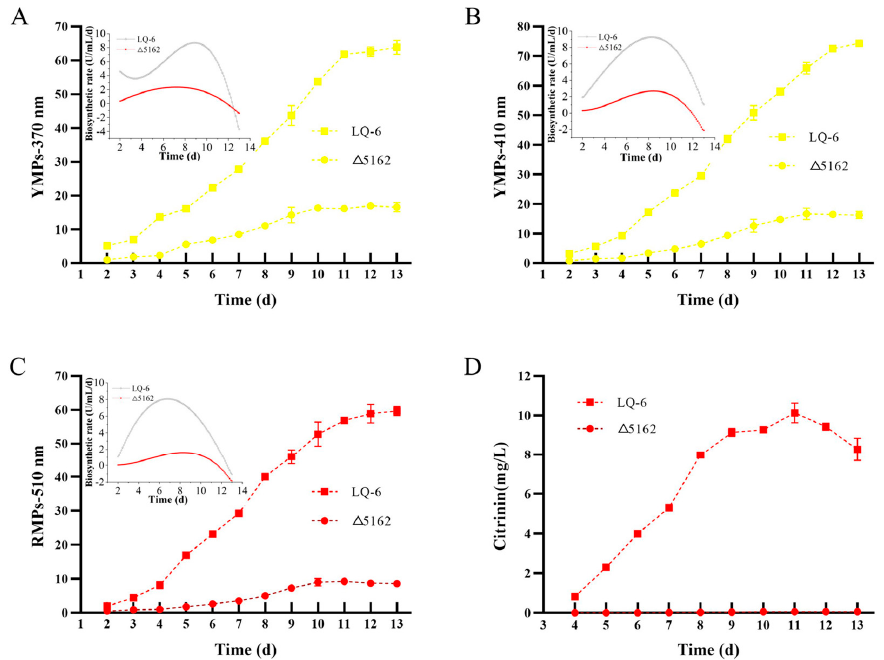
Figure 5. Submerged batch-fermentation kinetics analysis of M. purpureus LQ-6 and M. purpureus ∆ 5162. The biosynthesis of YMPs-370 nm ( A ), biosynthesis of YMPs-410 nm ( B ), biosynthesis of RMPs-510 nm ( C ), and biosynthesis of citrinin ( D ). Table 2. The effect of ployoxin B on biomass, Monascus pigments and citrinin production of M. purpureus LQ-6 in submerged fermentation for 10 days at 30 ℃ in the dark. Different letters in the same column indicate a significant difference ( p < 0.05).